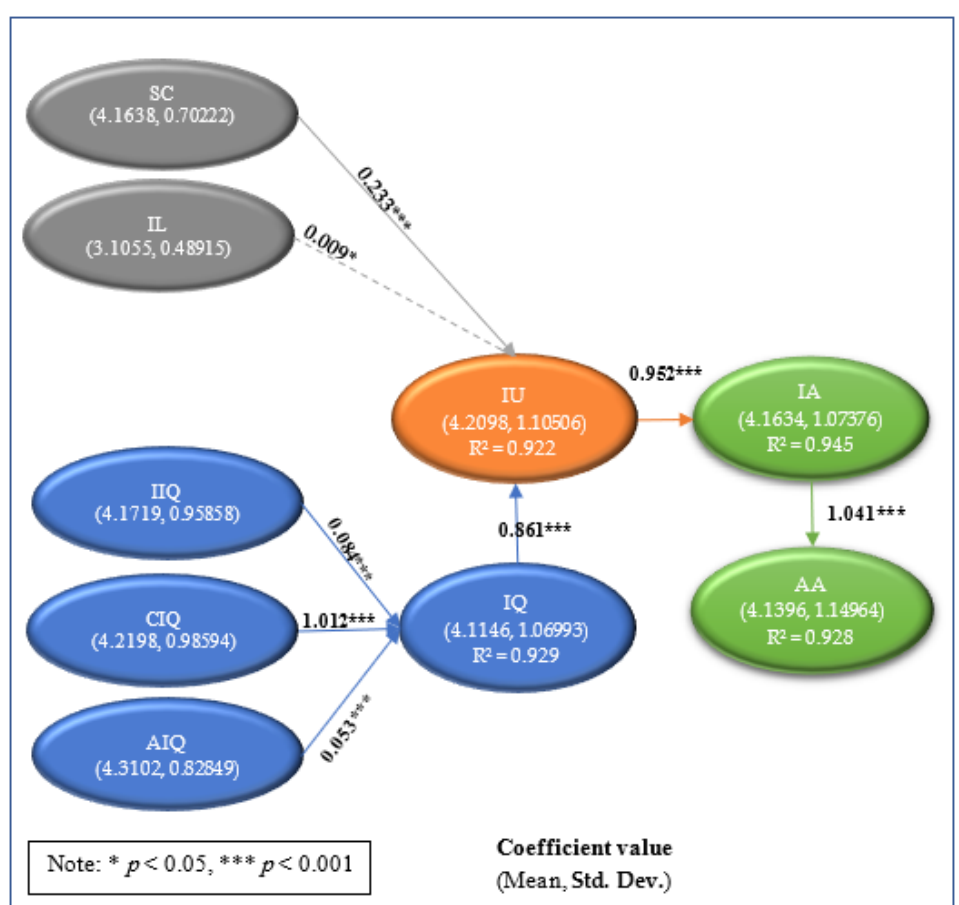
Figure 2. Proposed model with results’ coefficient value, mean, and Std. Dev. reflected.